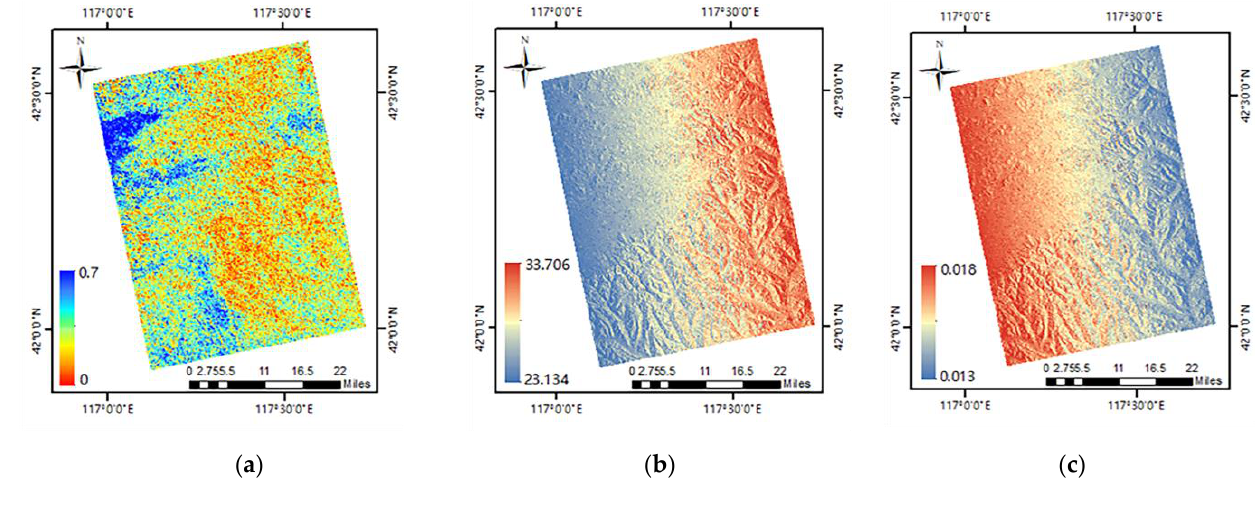
Figure 3. ( a ) HV polarization coherence image. ( b ) The local incidence angle. ( c ) The vertical wavenumber of the 0711-0725 interference pair obtained after image preprocessing.